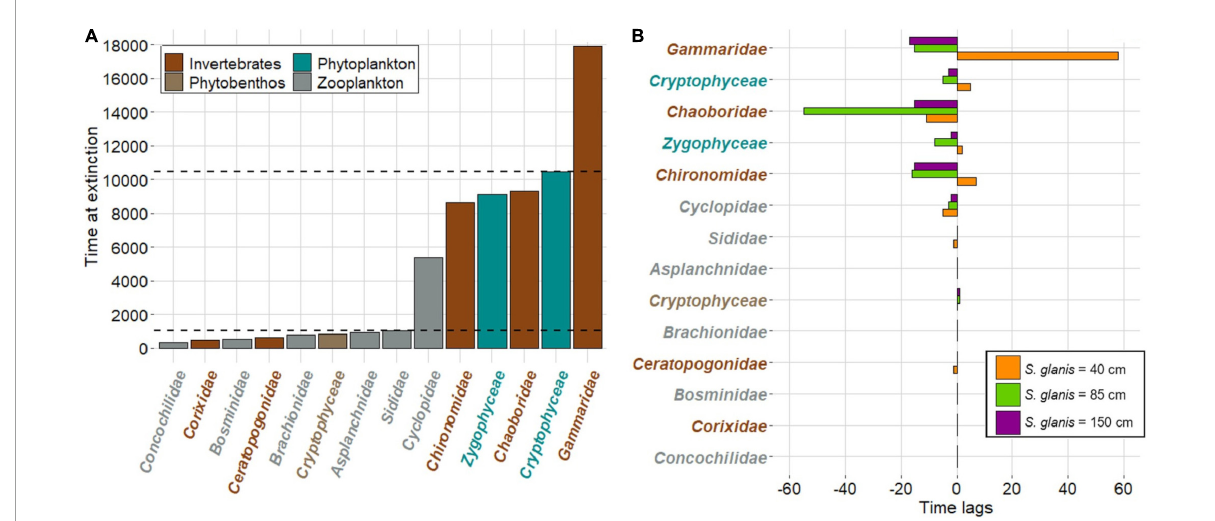
FIGURE2 Extinctions of species clusters (SC) in the whole invaded food-web typical of large French peri-Alpine lakes including independently S. glanis measuring 40, 85, and 150 cm. (A) Time at extinction over the 20,000 time steps for the SC are represented (three major extinction phases are delineated by horizontal dashed lines) and correspond to all scenarios. (B) Time lags between time at extinction associated with S. glanis invasion are represented according to the different invasion scenarios. SC are ordered by decreasing time at extinction (from top to bottom). Negative and positive time lags indicate extinctions occurring earlier and latter than without S. glanis invasion,